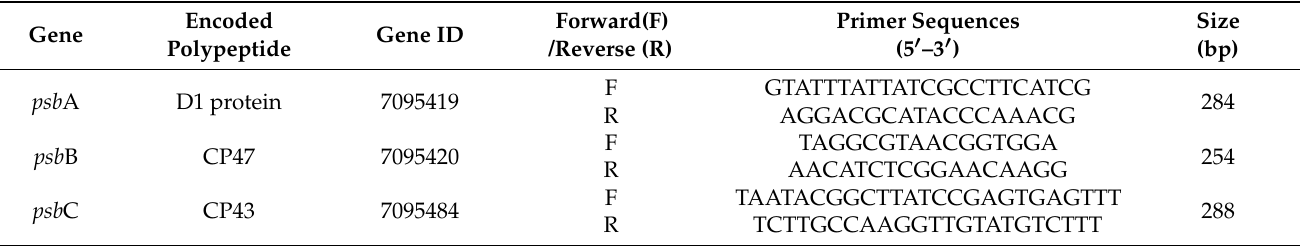
Table 1. Primer sequences and data used for RT-PCR